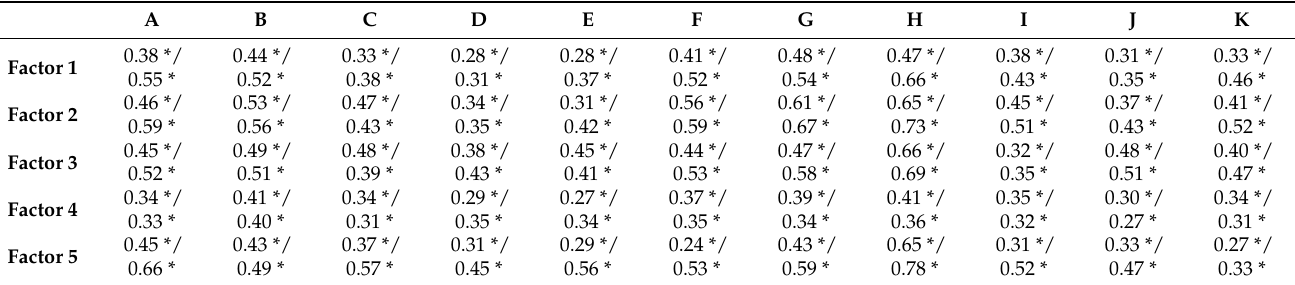
Table 3. Pearson product-difference correlation analysis of the factors of Health Behavior Inventory and occupational codes